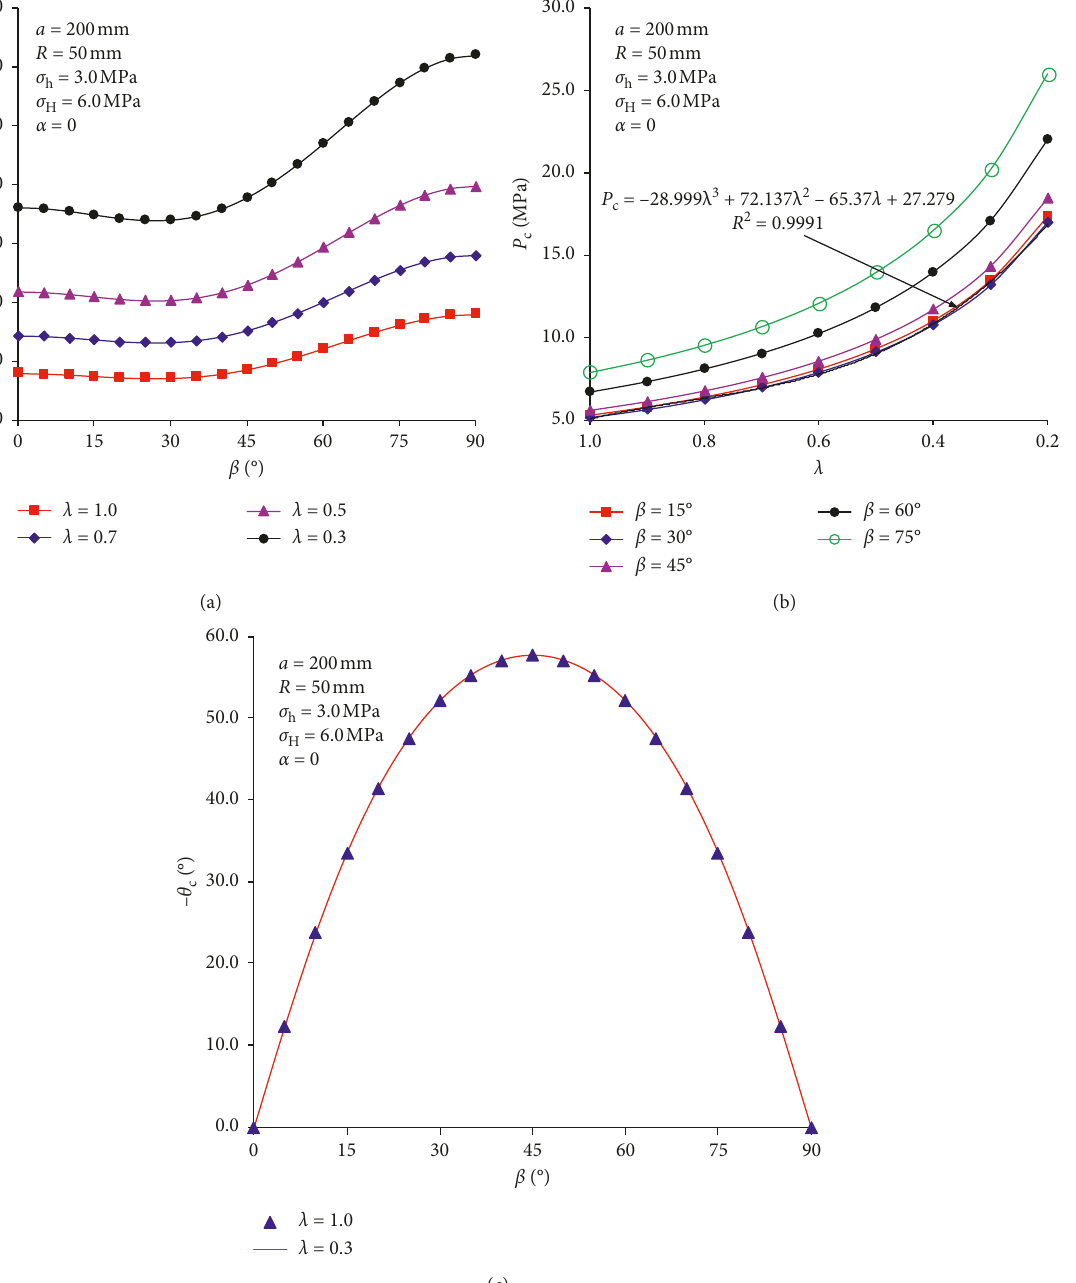
Figure 13: Effect of the ratio of water pressure in the fracture and the borehole on the critical water pressure and critical initiation Figure 13(a). With the decrease of the ratio λ , the critical water pressure increases rapidly according to a poly- nomial function of the parameter λ such as that shown in Figure 13(b) when β � 15 ° .